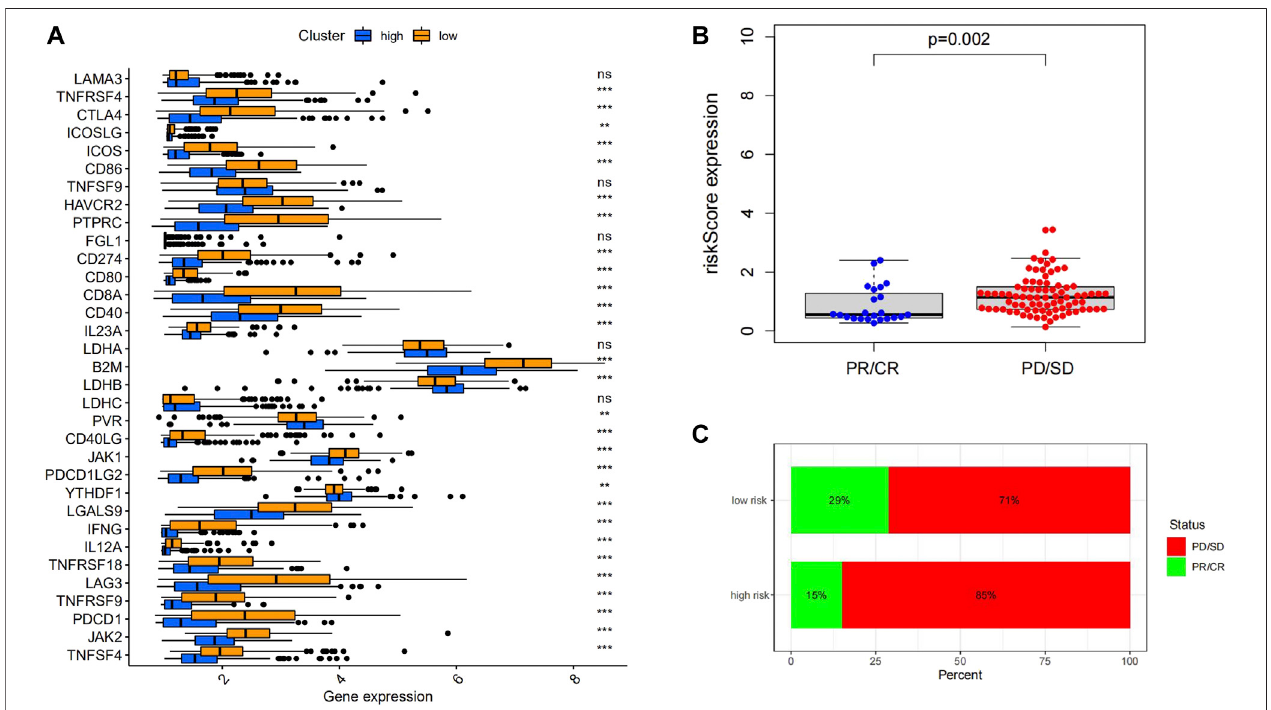
FIGURE 8 | (A) ICPs related genes were upregulated in the low-risk group. (B) Immunotherapy responders had signi fi cantly lower RiskScores than non- responders. (C) The proportion of responders in the low-risk group was higher than high-risk group. (D) The distribution of 22 immune cells was different between the high- and low-risk